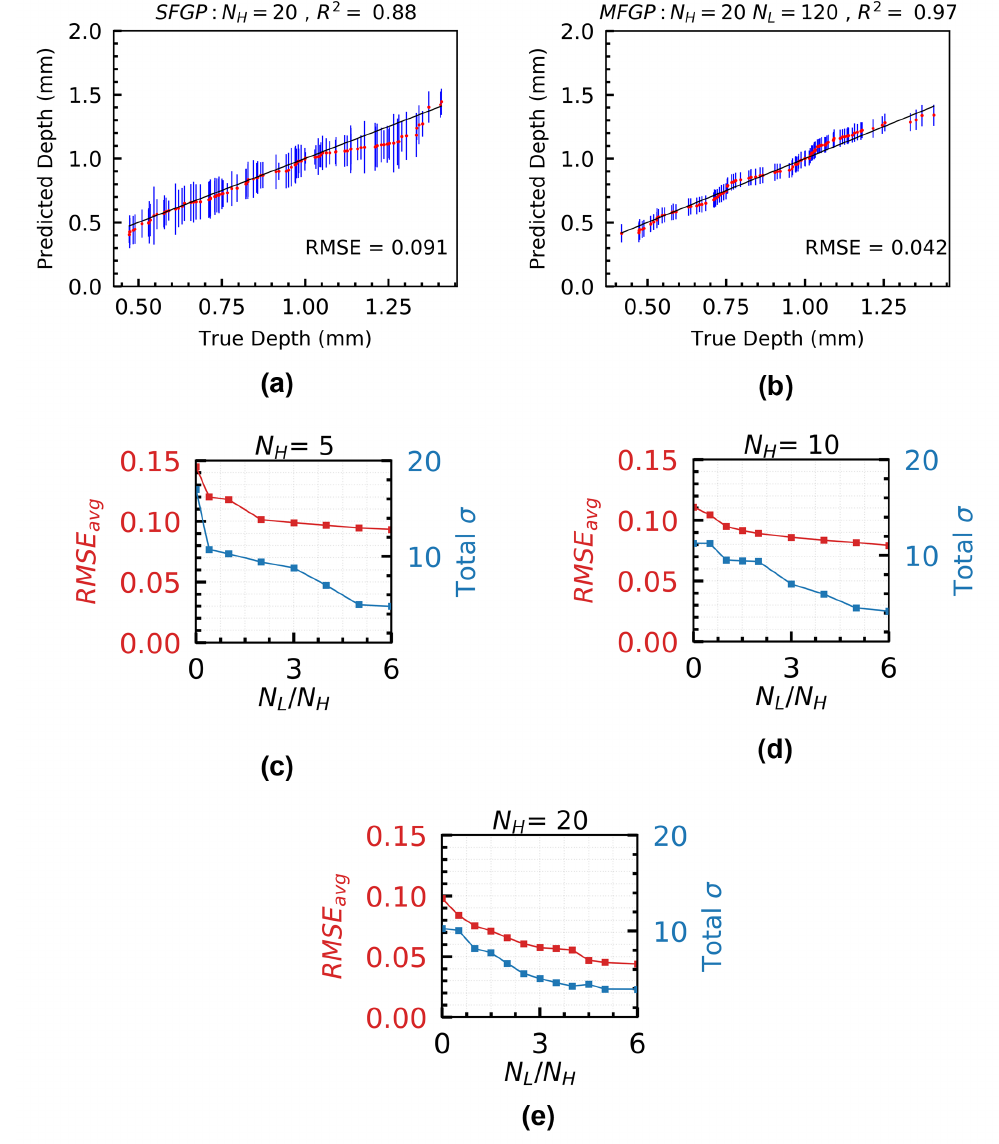
Figure 10. Parity plots for ( a ) SFGP with N H = 20 and ( b ) MFGP with N H = 20, N L = 120. Variation of RMSE avg and Total σ as a function of N L by keeping N H fixed at ( c ) 5 ( d ) 10, and ( e ) 20. N L / N H has been varied from 0 to 6. The performance of MFGP in predicting the melt pool depth is evaluated on a test set, X test of 100 randomly sampled points from X space . The results reported are the corresponding averages of RMSE and σ over 50 different initializations of the